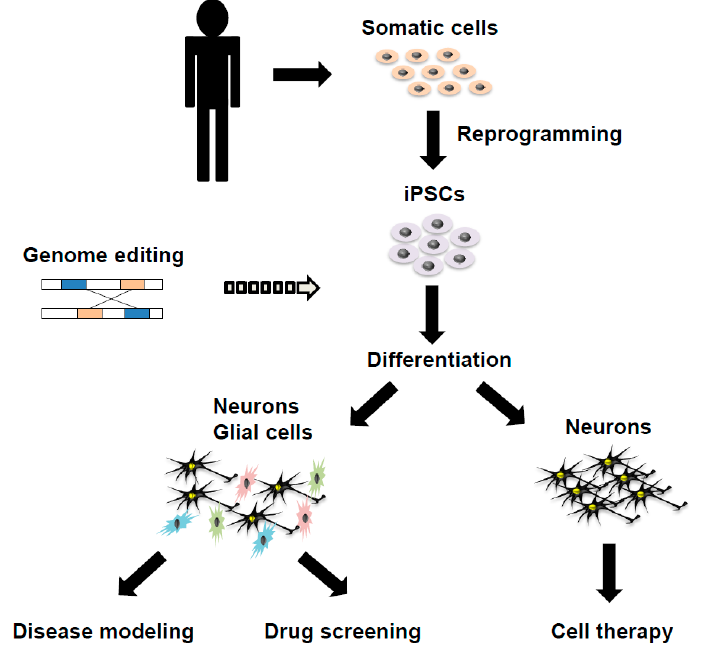
Figure 1. A schema showing the generation of disease-specific induced pluripotent stem cells (iPSCs) and its applications in disease modeling, drug screening and cell therapy on Parkinson’s disease and atypical parkinsonian syndromes.